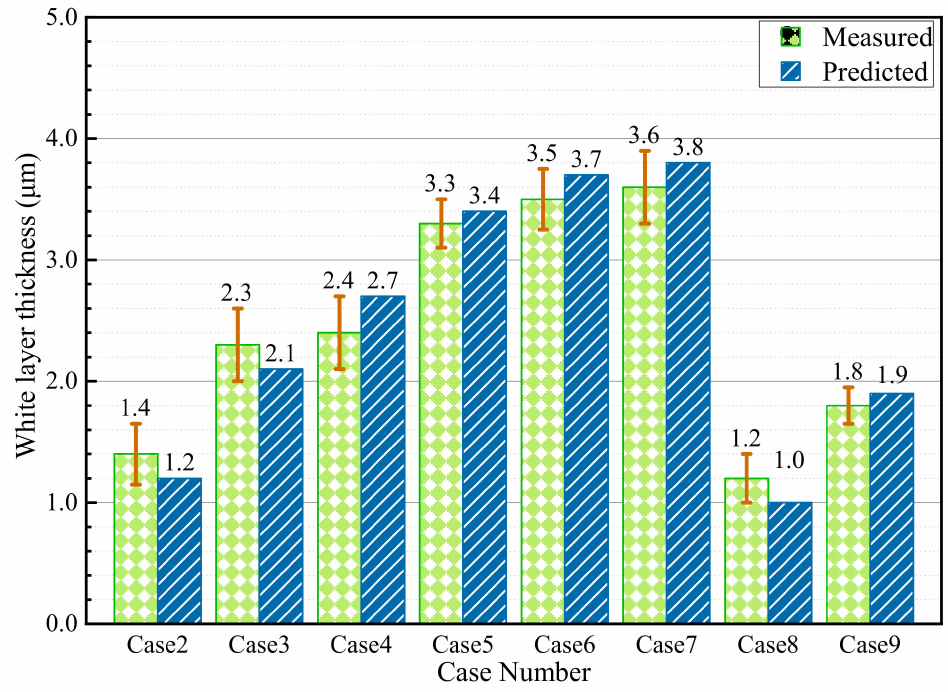
Figure 10. White-layer thickness of AerMet100